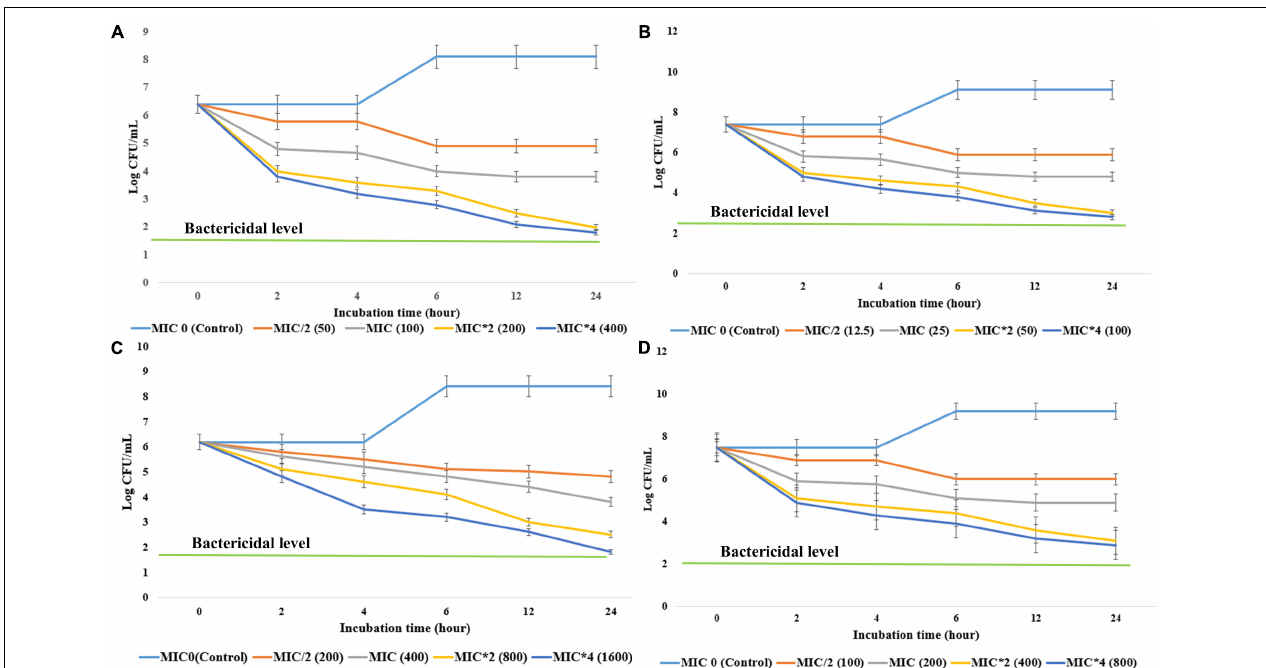
FIGURE 3 | The effect of different concentrations (minimum inhibitory concentrations: MIC/2, MIC, MIC*2, MIC*4) of antibacterial compounds of HelS1 on the growth of bacterial pathogens [ (A) methicillin-resistant Staphylococcus aureus (MRSA), (B) S . epidermidis , (C) S . dysenteriae , (D) K . pneumonia ] is represented here in the form of a time-kill curve. The CFUs (colony-forming units) are counted after 0, 2, 4, 6, 8, 10, 12, and 24 h of treatment. Values on the graphs are the means ± standard error (SE) of the three replicates.